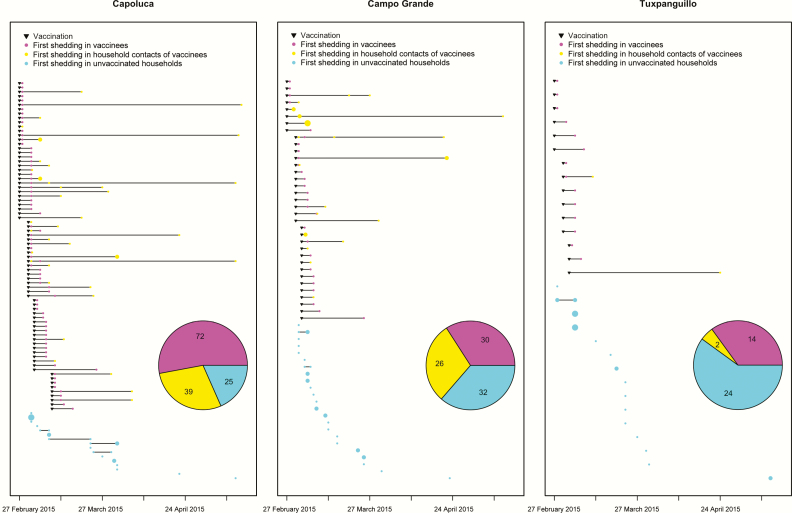
Vaccinations and first shedding events by household. A shedding event was defined as the presence of ≥1 serotype in a stool sample, and only the first shedding event for each individual is displayed. Each row corresponds to a household, and the size of points is scaled to case numbers. Pie chart shows the cumulative number of shedding events in vaccinees, household contacts of vaccinees, and unvaccinated households. (Households that were enrolled in the Mexico study but provided no positive stool samples throughout the study period are not shown.)